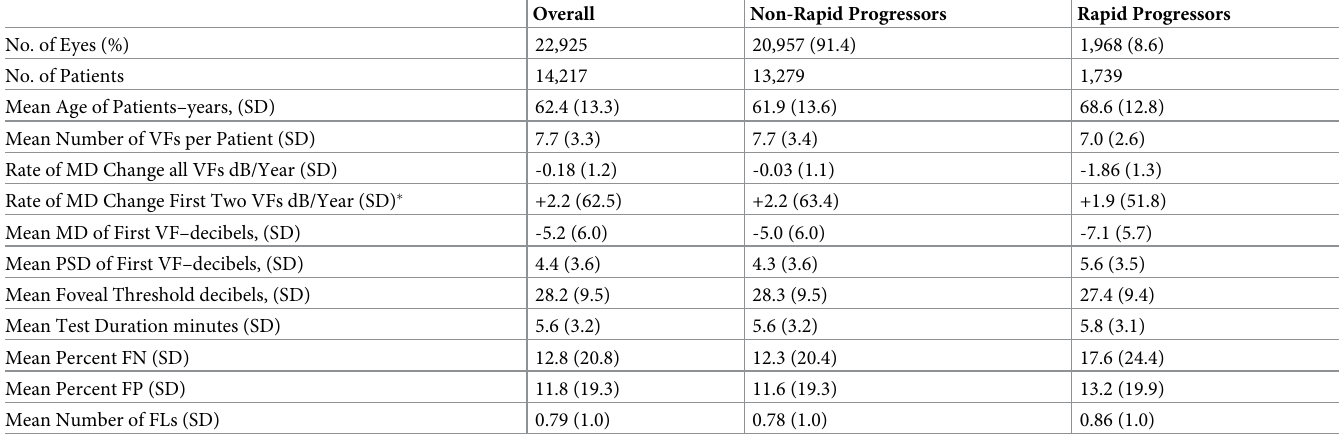
Table 2. Demographic of patients with visual field data �